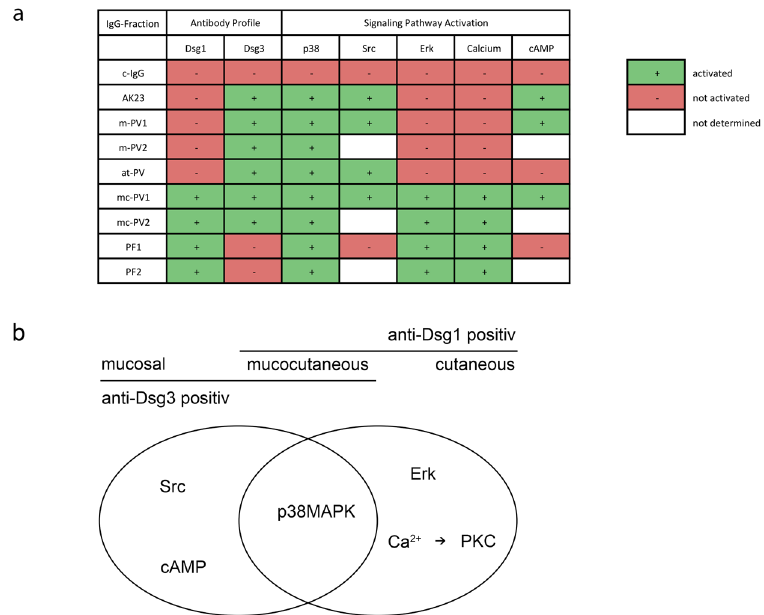
Figure 5. Signaling patterns associated with autoantibody profiles. Summary ( a ) and schematic ( b ) representation of signaling patterns associated with different autoantibody fractions and their respective clinical